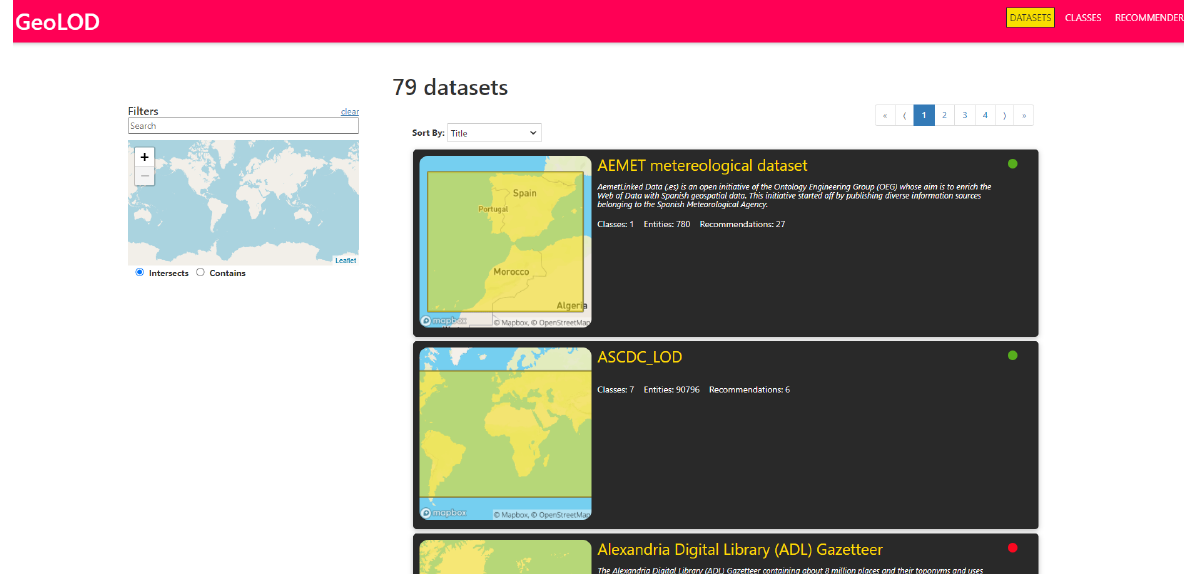
Figure 2. GeoLOD home page with the list of linked data spatial